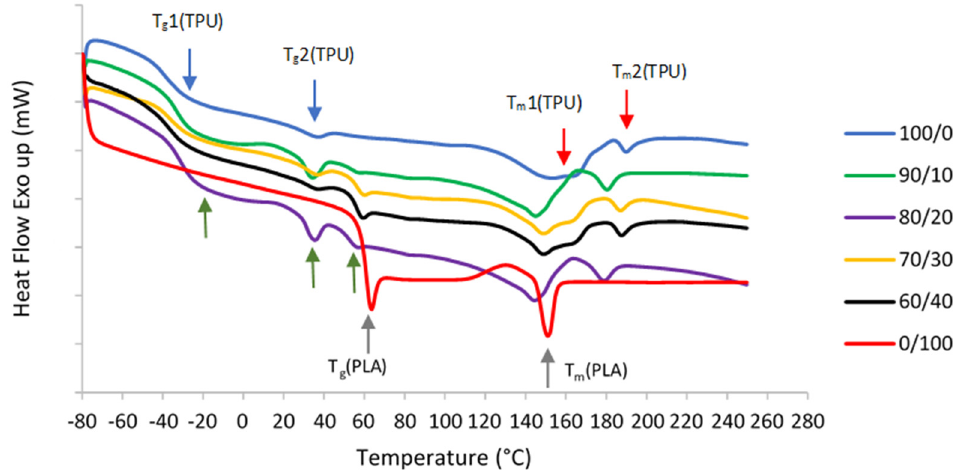
Figure 3. DSC secondary melting curves of pure TPU and PLA, and TPU/PLA blends. The blue arrows show the first and second T g values of pure TPU, while red arrows indicate both T m values of pure TPU. Grey arrows show the T g and T m values of pure PLA. Finally, the green arrows depict all three T g values of TPU/PLA blends.